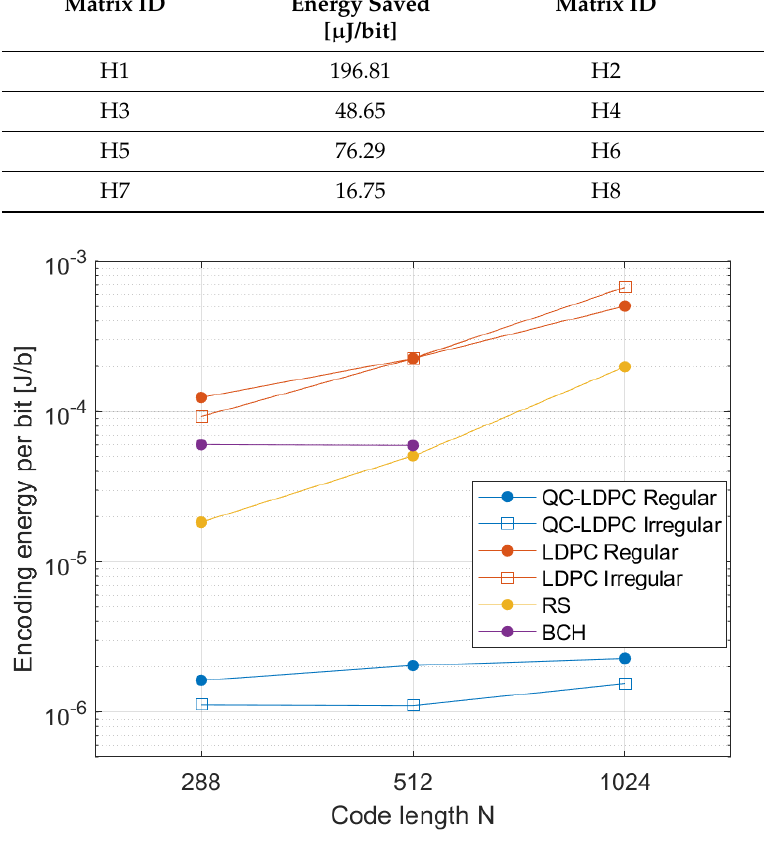
Figure 8. Encoding energy needed per bit vs. code